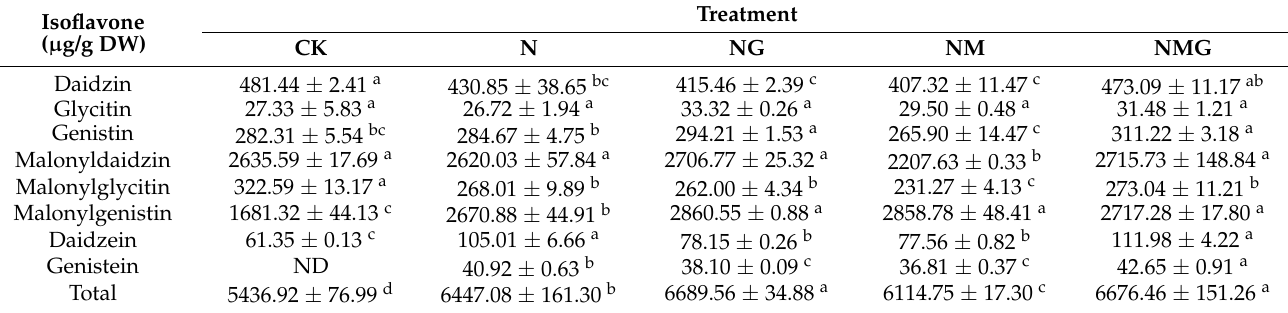
Table 3. Effects of GABA on isoflavone content in soybean sprouts under NaCl stress ( n =